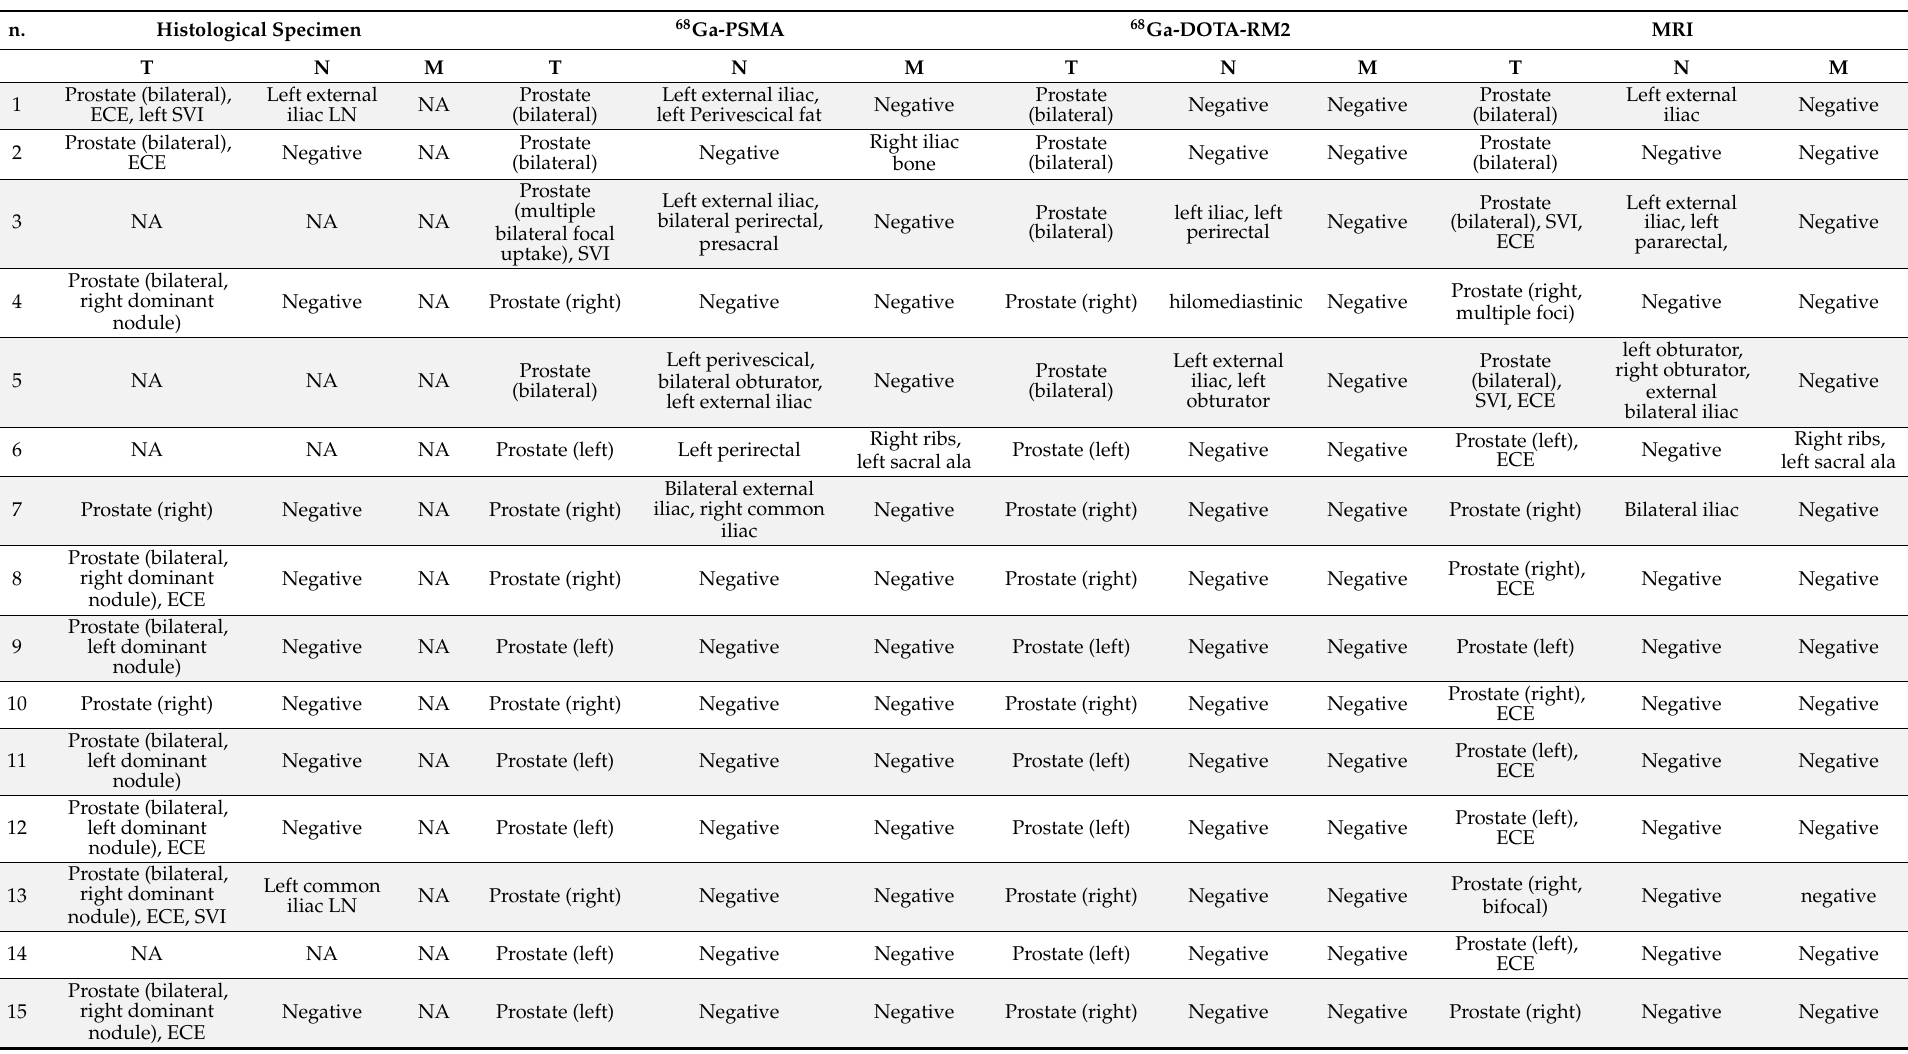
Table 2. TNM findings of 68 Ga-PSMA, 68 Ga-RM PET/MRI and histological